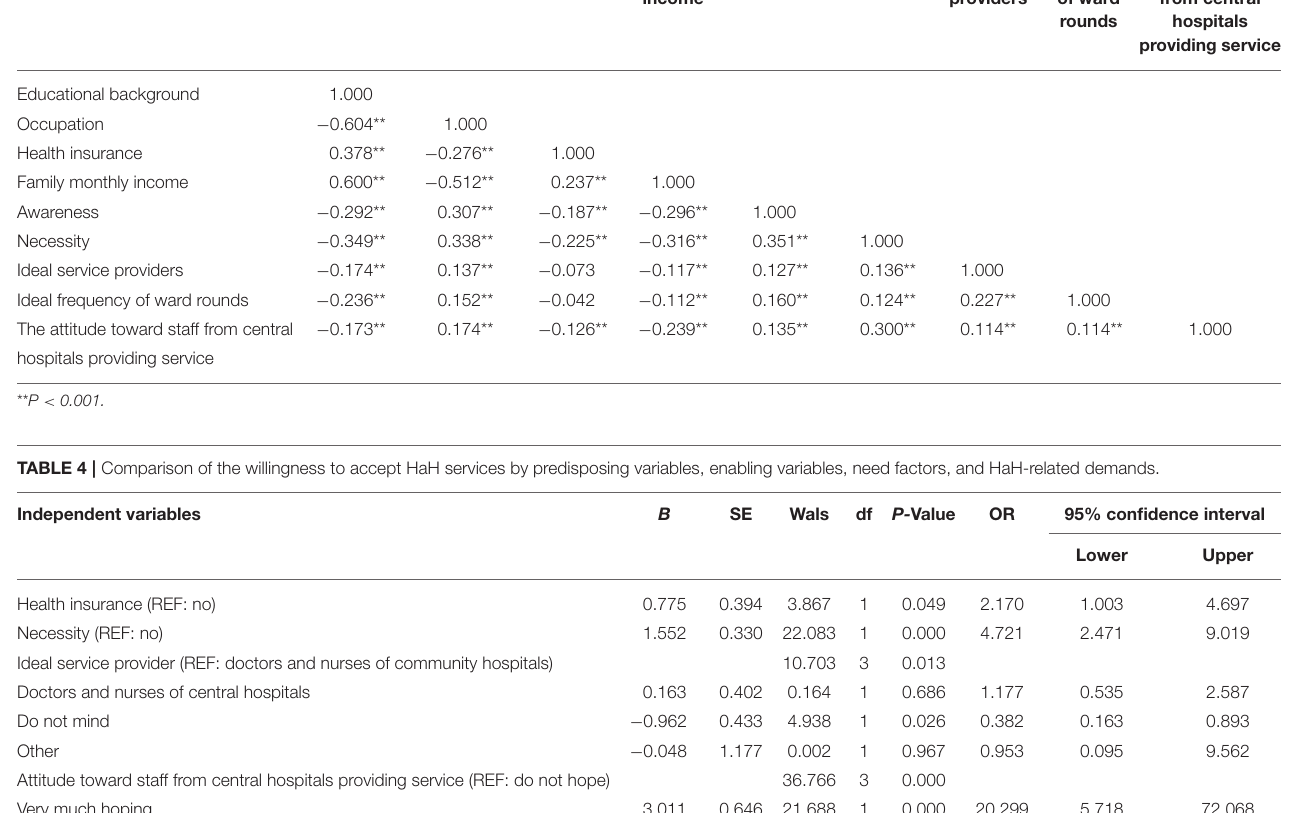
income providers